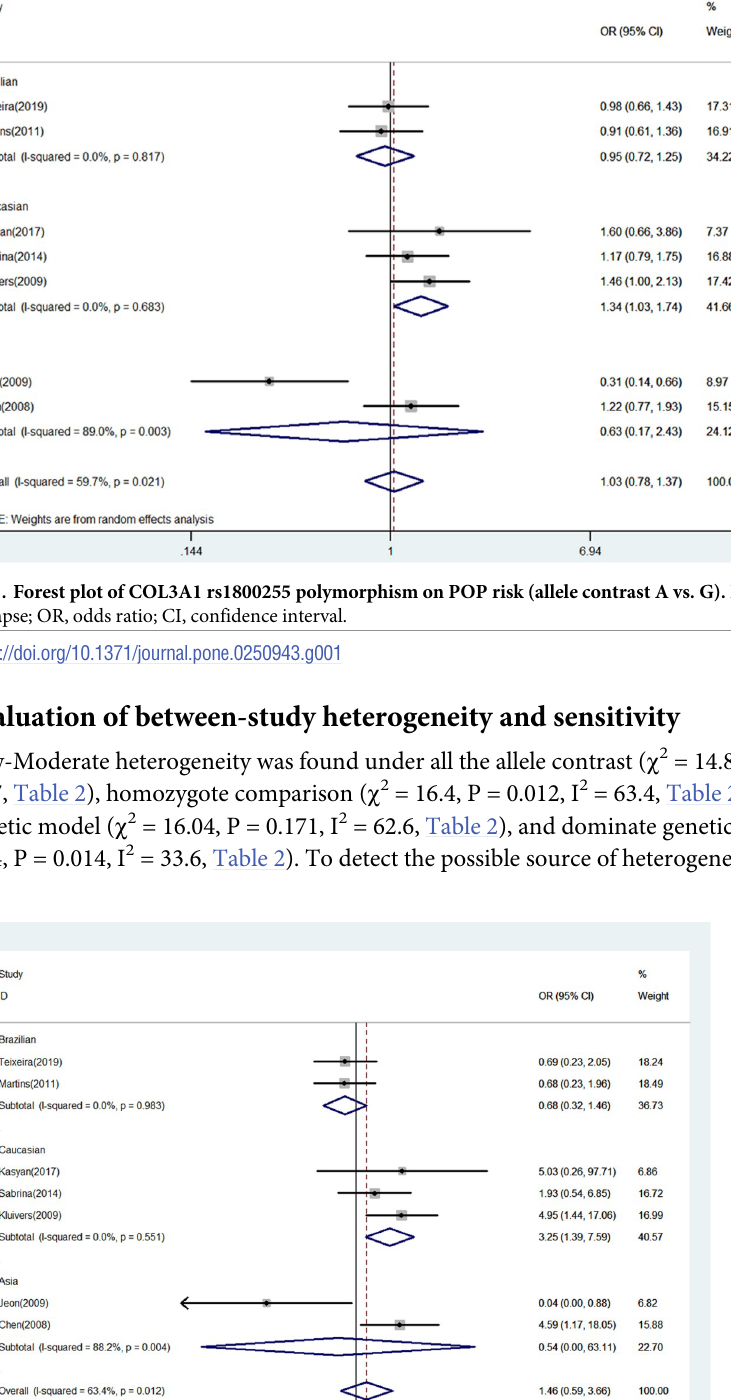
Fig 2. Forest plot of COL3A1 rs1800255 polymorphism on POP risk (homozygote comparison: AA vs. GG). POP, pelvic organ prolapse; OR, odds ratio; CI, confidence interval.